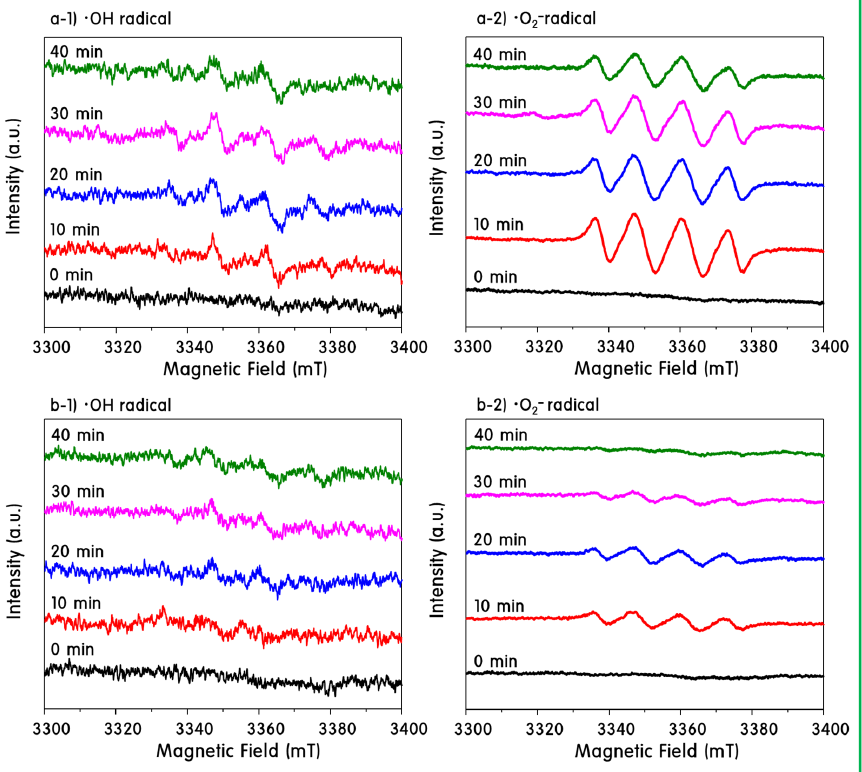
Figure 10. Spin-trapping ESR spectra in the presence of spin-trapping agent DMPO ( a1 – a2 ) ZnO-200 nanoplates DMPO-radical signals according to time change, ( b1 – b2 ) ZnO-50 nanoplates DMPO-radical signals according to time change.